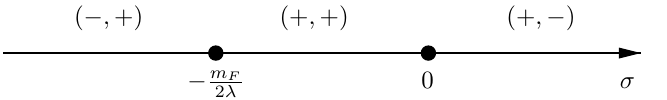
Figure 6. Regions of validity for di(cid:11)erent branches of the potential for sgn( m F )sgn( (cid:21) ) =